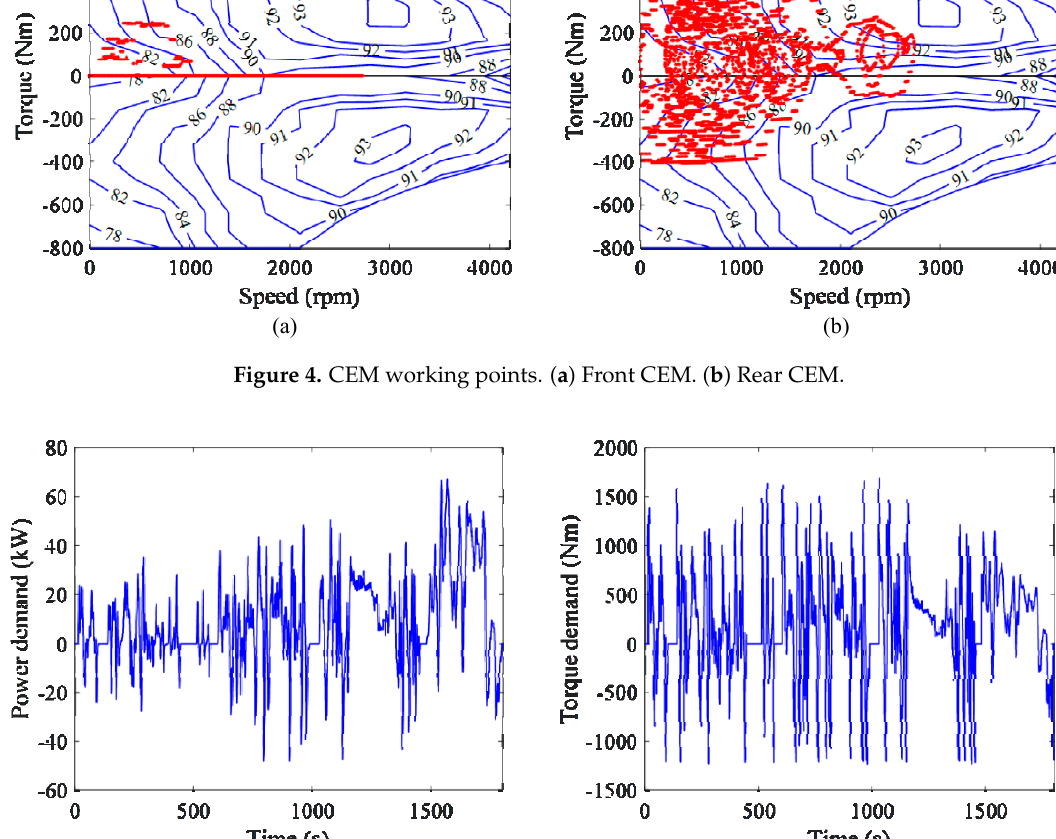
Figure 5. CEV power demand during WLTP-3.